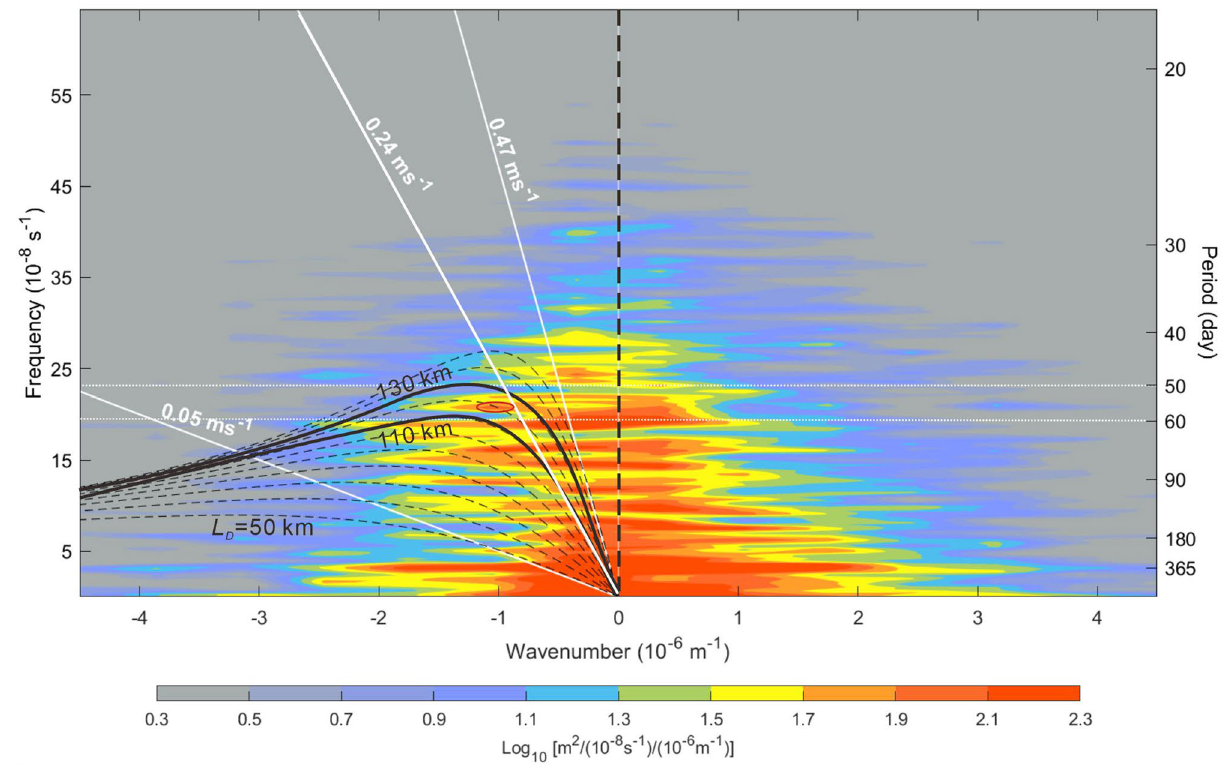
Figure 4. Frequency-wavenumber spectrum of satellite SLA. The frequency-wavenumber spectrum was calculated from a 17-year (2001–2017) satellite SLA dataset. The black dashed curves represent dispersion relations of Rossby waves calculated using the dispersion relation of Rossby wave at baroclinic Rossby deformation radius L D from 50 to 150 km with an increment of 10 km. The two black thick curves mark dispersion relations at L D = 110 and 130 km. The oblique white lines indicate phase speed of 0.05, 0.24, and 0.47 m s –1 . The color shading indicates the energy density of the SLA oscillations. The red oval indicates westward-propagating energy density hump within periods 50 and 60